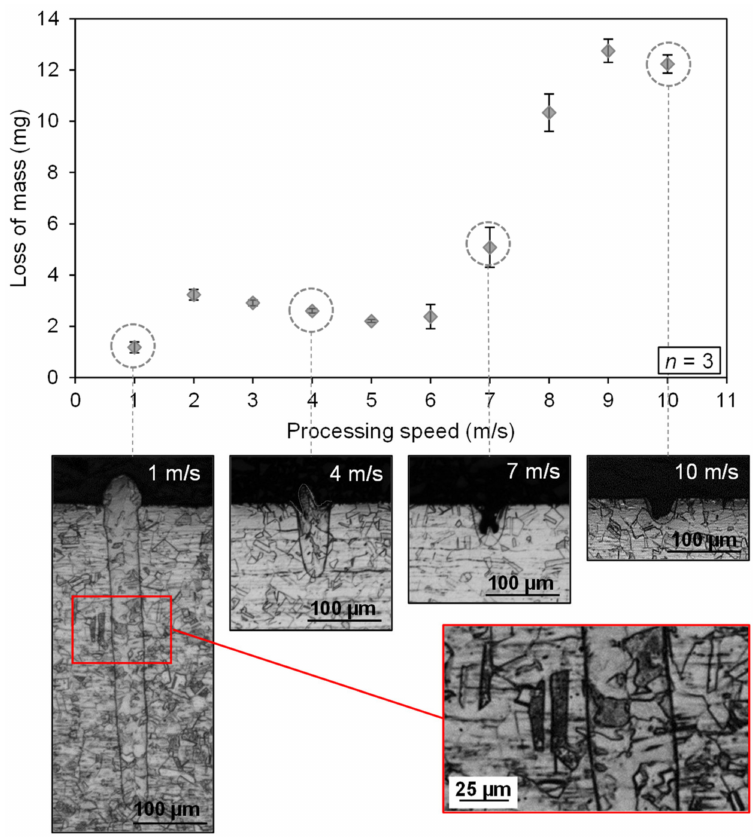
Figure 2. Resultant loss of mass with corresponding